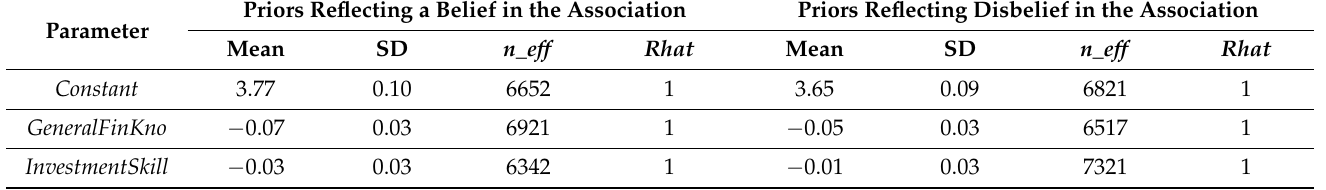
Table 2. Model 2’s simulated posterior coefficients. Table 2. Model 2 ′ s simulated posterior coefficients.